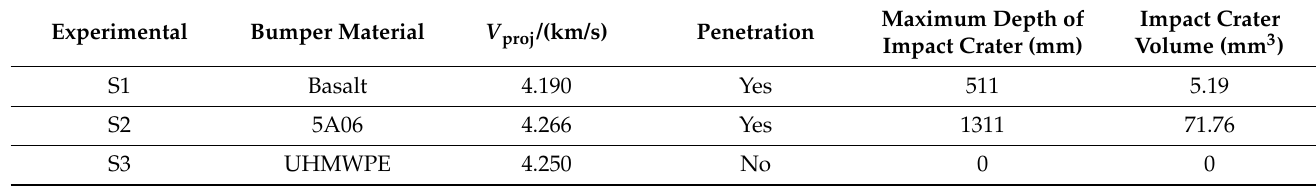
Table 2. Impact test